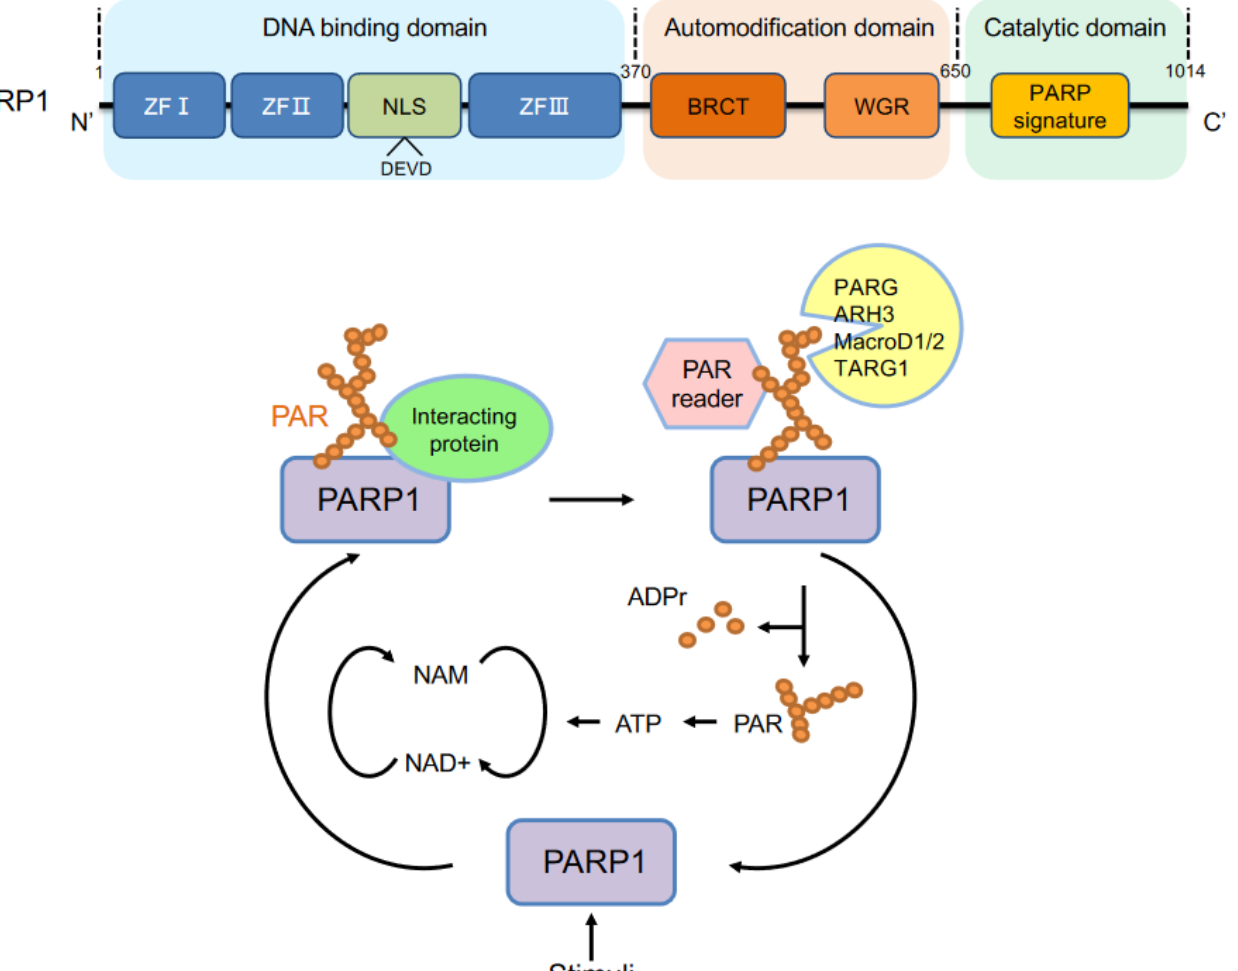
Figure 1. PARP1 structure and PARylation. ( A ) Structural and functional domains of human PARP1. ZFI, ZFII and ZFIII: zinc finger motifs I, II and III, respectively; NLS: nuclear localization signal; DEVD: a caspase cleavage site; BRCA1 C-terminus (BRCT); WGR (Trp–Gly–Arg). A highly conserved PARP signature is located in the C-terminal catalytic domain. ( B ) The cycle of PARylation as depicted by auto-PARylation of PARP1, a well-documented acceptor. Stimuli, including but not limit to, DNA damage, ERK1/2, hormone, JIL-1, activate PARP1, which catalyzes the formation of long and branched poly (ADP-ribose) (PAR), using NAD+ as a substrate. PARP1 can interact with other partners, either by itself as a scaffold protein or via its enzymatic product PAR. PAR can be recognized by PAR readers and be rapidly degraded by hydrolytic enzymes, PARG, ARH3, MacroD1 and D2, TARG1. NAM: nicotinamide; ADPr: ADP-ribose; PAR: poly (ADP-ribose).